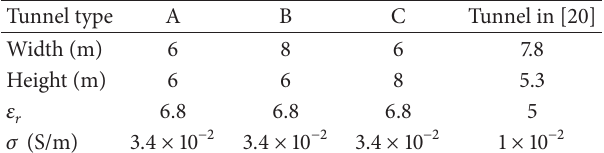
Table 1: Tunnel parameters.